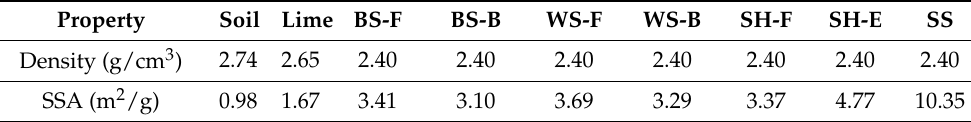
Table 5. Density and specific surface are (SSA) of the used